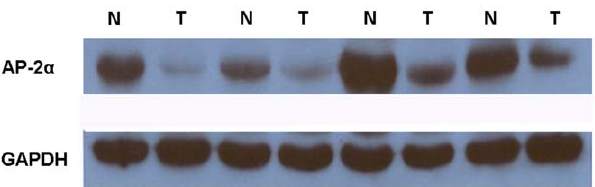
Figure 2. Western blotting analysis of AP-2 a expression in gastric cancer patients. Relative expression of AP-2 a in gastric cancer tumor (T) tissues compared to adjacent non-tumor (N) tissues (n=41) assessed by western blotting,